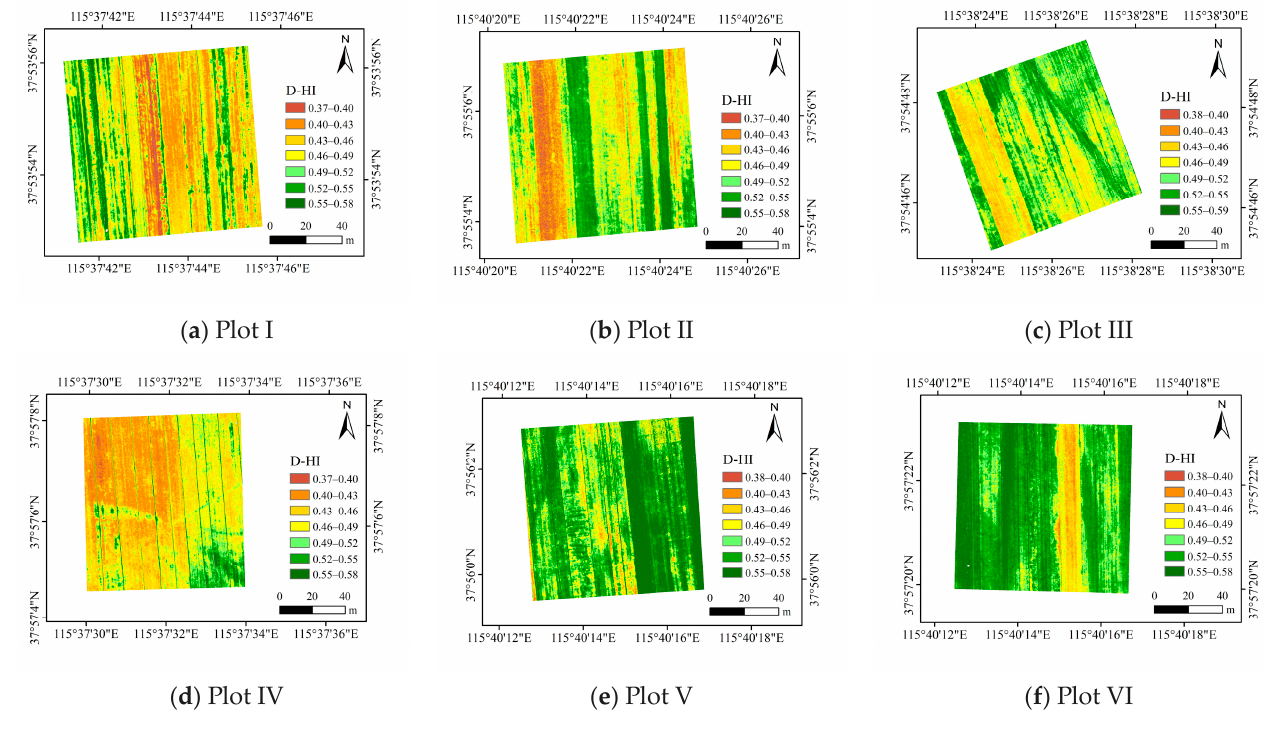
Figure 13. D-HI estimation results based on the sensitive band centers λ (724 nm, 784 nm) (25 May 2021).